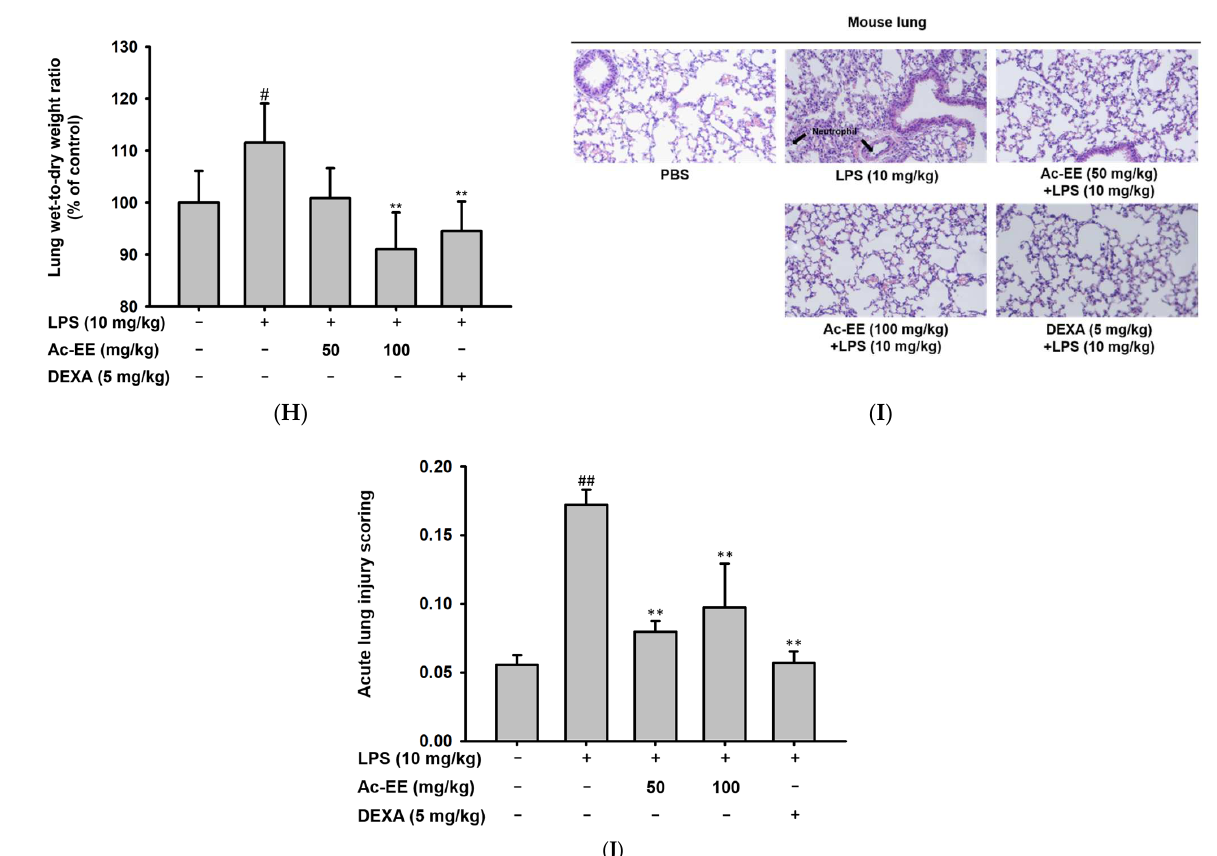
Figure 2. Suppressive effects of Ac-EE on NO production in murine macrophages and lung inflam- mation in an acute lung injury mouse model. ( A – C ) NO synthesis was measured in RAW264.7 cells stimulated by LPS (1 μg/mL), Poly (I:C) (200 μg/mL), or Pam3CSK4 (10 μg/mL) in the presence (25–100 μg/mL) or absence of Ac-EE. ( D ) NO production from LPS-activated peritoneal macrophages was detected with different concentrations of Ac-EE. ( E , F ) Cytotoxicity levels of Ac-EE in RAW264.7 cells and peritoneal macrophages were determined. ( G ) Overview of the in vivo acute lung injury mouse model with LPS induction. ( H ) The degree of lung edema was calculated by measuring the wet-to-dry weight ratio. ( I ) Histological photographs of pulmonary tissues observed under a micro- scope after H&E staining. Black arrows show neutrophils in lung tissues. ( J ) Lung injury score was measured by counting the number of neutrophils, the generation of hyaline membrane, and alveolar septal thickening. #, p less than 0.05 and ##, p less than 0.01 relative to the normal group; and **, p less than 0.01 relative to the LPS induction or vehicle group.